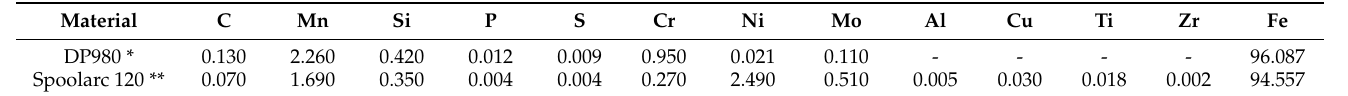
Table 1. Chemical composition of the DP980 and filler metal (wt.